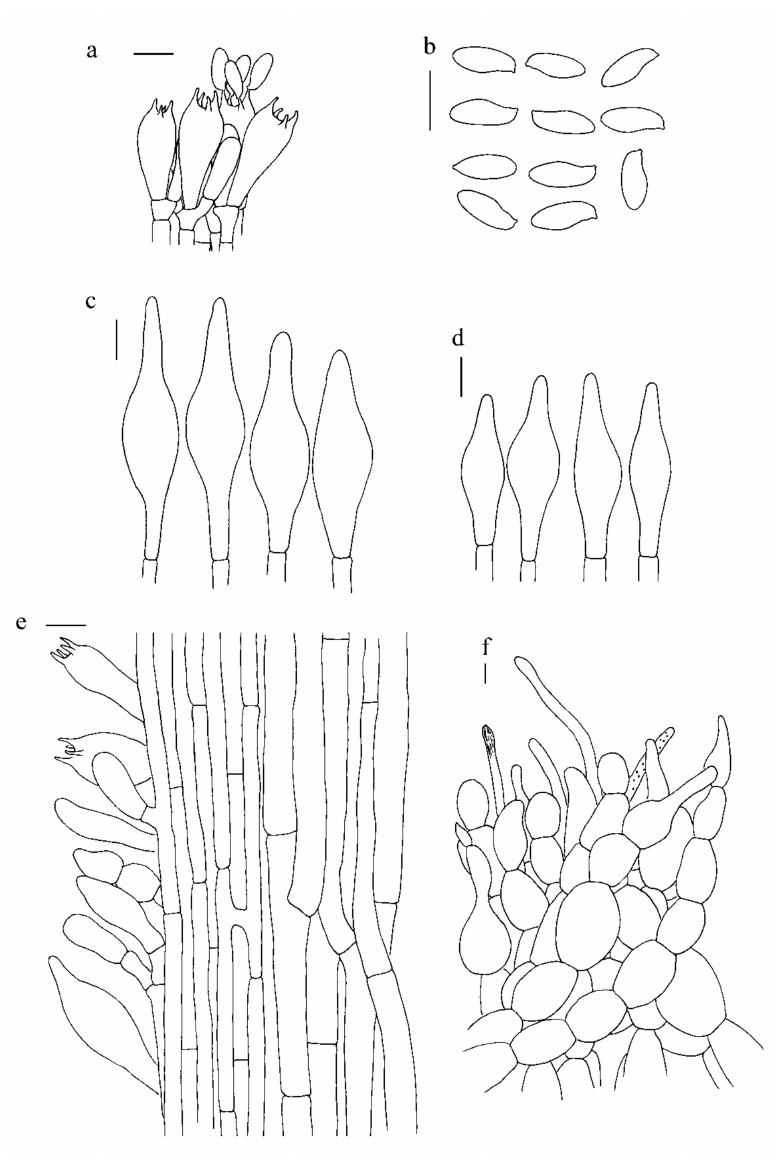
Figure 6. Microscopic features of H. brevisporum (Type, KUN-HKAS89150). ( a ). Hymenium and subhymenium; ( b ). Basidiospores; ( c ). Pleurocystidia; ( d ). Cheilocystidia; ( e ). Stipitipellis; ( f ). Pileipellis. Bars : a = 20 µ m, b = 30 µ m, c–e = 20 µ m, f = 10 µ m. Basidia 18.5–27.0 × 8–11 µ m, clavate, hyaline in 5% KOH, 4-spored.